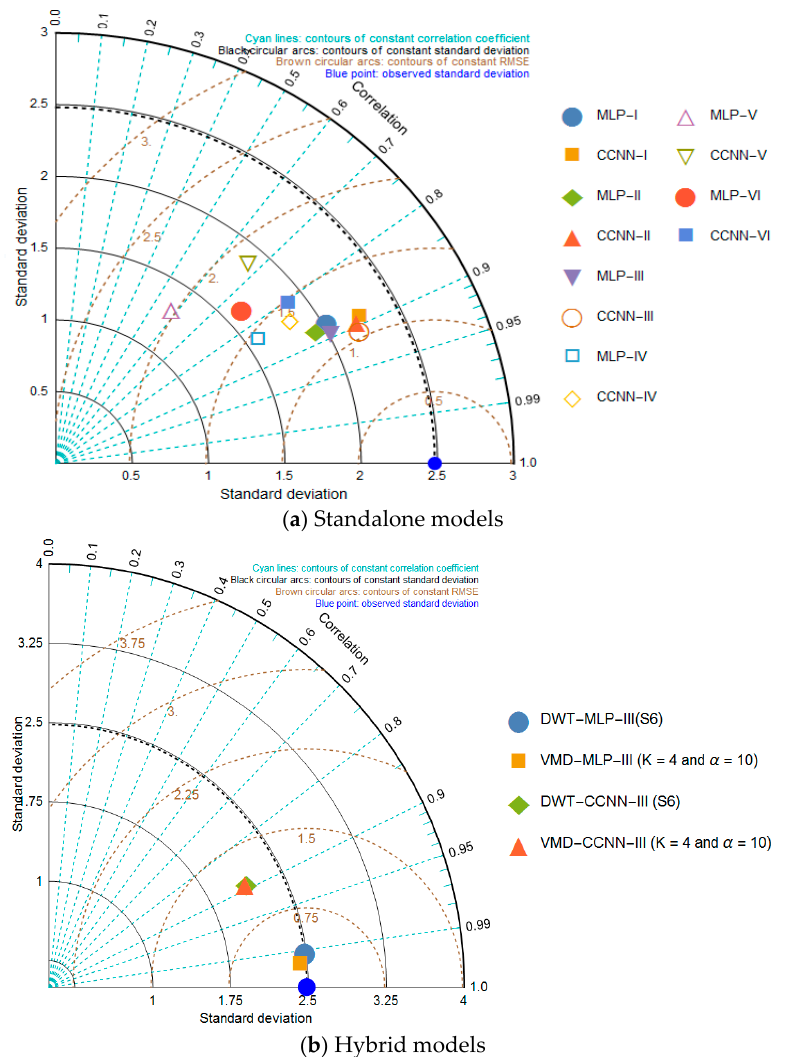
Figure 13. Taylor diagrams for evaluating the performance of the applied models.